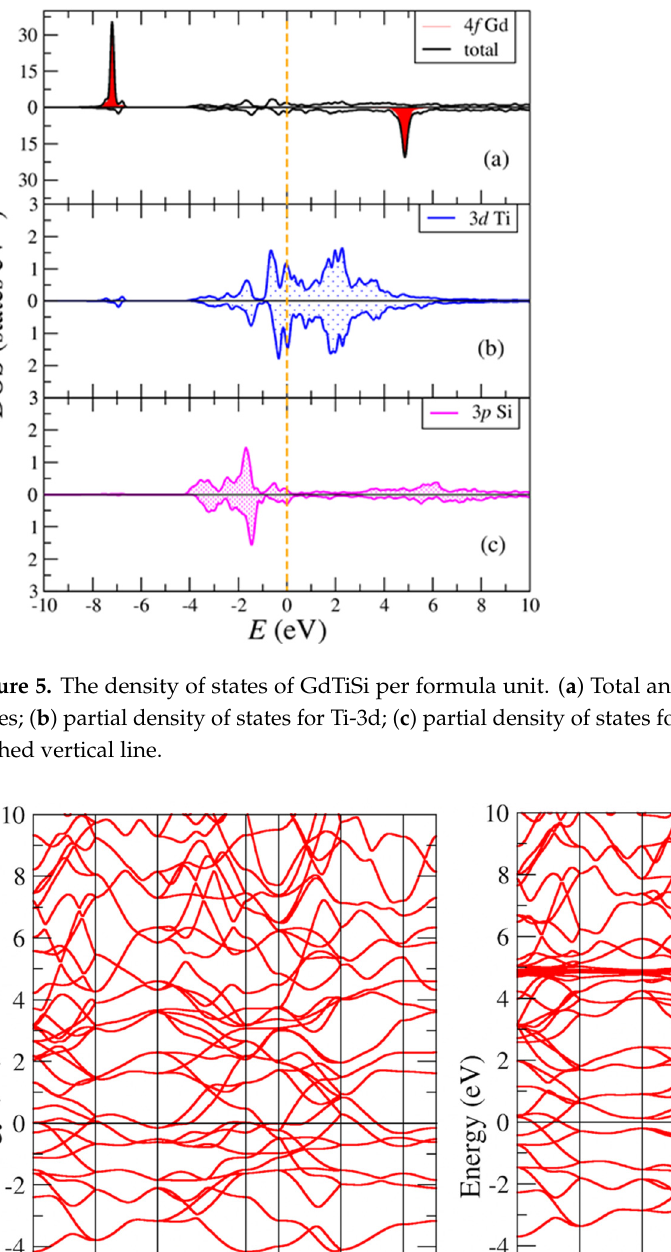
6 of 12 Figure 4. Band structure of GdMnSi. ( a ) Majority spin projection; ( b ) minority spin projection. The Fermi level is a solid horizontal line. The calculated densities of electronic states and band structure of GdTiSi are shown in Figures 5 and 6. Similar sharp peaks can be traced near − 7 and 5 eV in Figure 6, stemming from the spin-polarized Gd-4f electronic states. The densities of states in the GdMnSi and GdTiSi compounds are different for two opposite spin directions, since the resulting state is ferromagnetic both in the Gd lattice and in the sublattice of 3d metals.